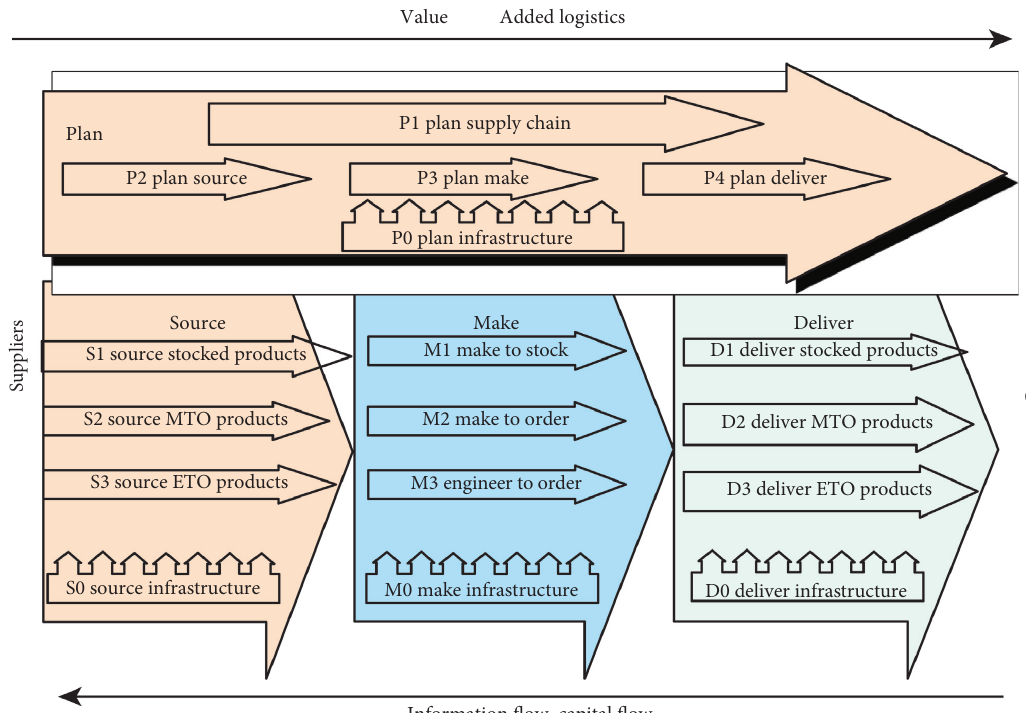
Figure 1: Framework of supply chain